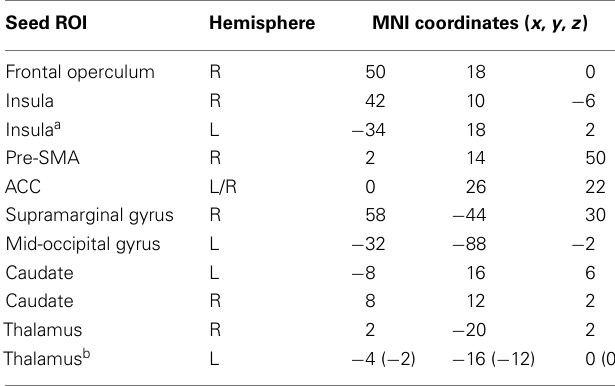
Table 3 | MNI152 standard space coordinates for seed regions used in the functional connectivity